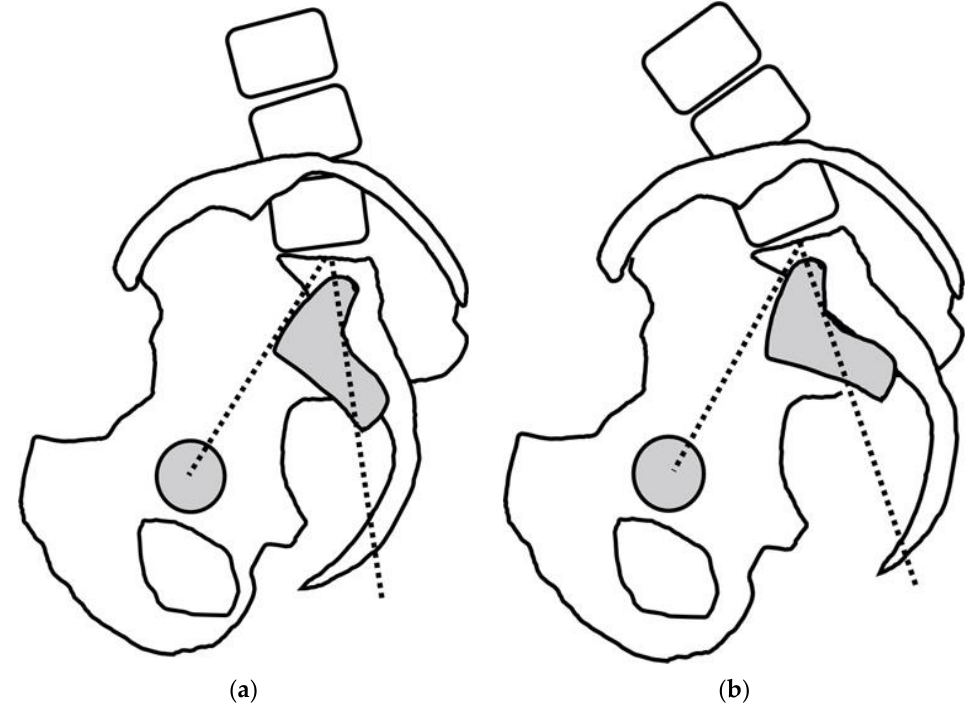
Figure 2. “Increasing sacroiliac joint angulation” associated with lumbar kyphosis, posterior pelvic tilt, and sacroiliac joint degeneration. ( a ) Pelvis tilted posteriorly with lumbar kyphosis. ( b ) The trunk tilts forward, and the sacrum tilts forward, “increasing the angle of the sacroiliac joint” and resulting in a higher PI. Reference [26] are cited and modified with permission from the editorial office of the Journal of Spine research.